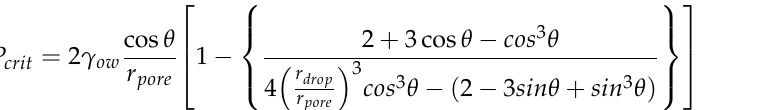
Figure 1. Illustration of an oil droplet attached on the surface of the membrane. In general, membrane surface wettability can be categorised into four regimes: (1) superhydrophobic (water contact angle > 150 ◦ ), (2) hydrophobic (water contact angle > 90 − 150 ◦ ); (3) hydrophilic (water contact angle < 90 ◦ ) and (4) superhydrophilic (water contact angle ~0–10 ◦ ). For the case of low surface tension liquid such as oil, the gen- eralisation can be classified as (1) superoleophobic (oil contact angle > 150 ◦ ); (2) oleophobic (oil contact angle > 90 ◦ ); (3) oleophilic (oil contact angle < 90 ◦ ); and (4) superoleophilic (oil contact angle~0–10 ◦ ). The attachment of oil droplets to measure surface wettability is illustrated in Figure 2. Oil droplets can permeate the membrane at applied pressure greater than the critical pressure [1,63]. According to the reference article, the critical pressure can be calculated by using the following